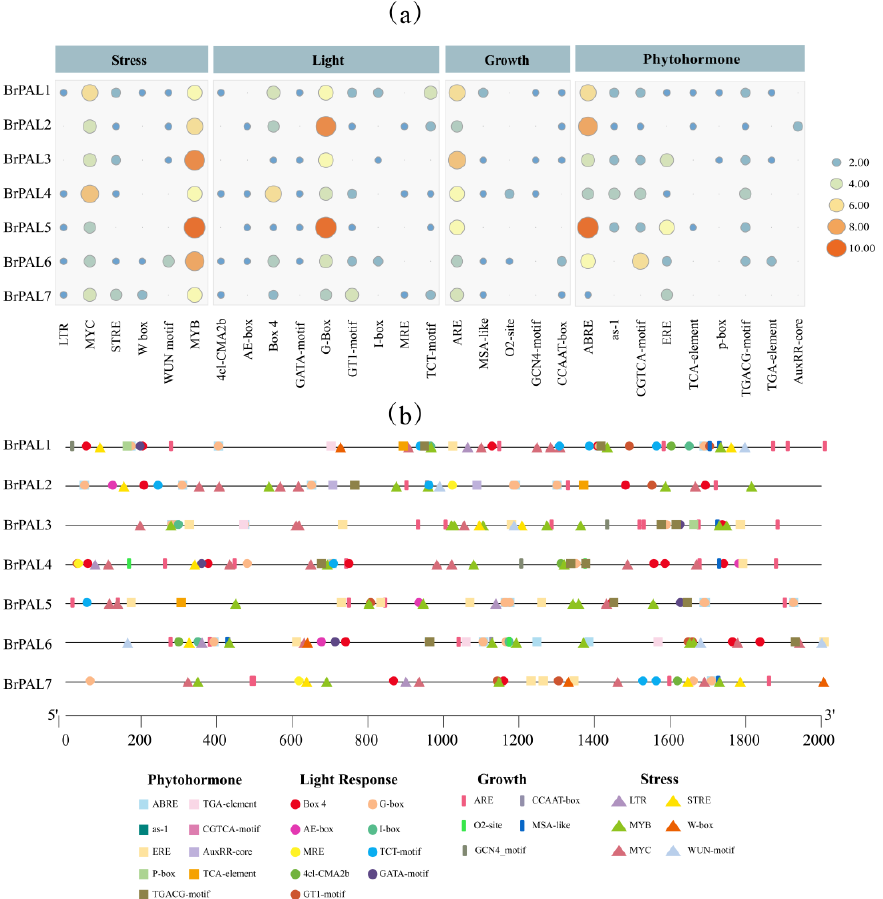
To further explore the potential role of cabbage PAL genes under different light quality, abiotic stresses and hormone treatments, we analyzed their expression levels using qRT-PCR. As shown in Figure 7, all members were down-regulated under FR and FU treatment, and all genes were up-regulated under UVA treatment except for BrPAL2 and BrPAL5 . As shown in Figure 8, only BrPAL2 and BrPAL5 expressions were up-regulated under heat stress reaching peaks at 6 h and 3 h, respectively, while the rest of the genes remained at low expression levels; except for the downregulation of BrPAL5 , the expression levels of other members were relatively high under treatment at low temperatures. The expression levels of BrPAL1 , BrPAL2 , and BrPAL3 at 0 – 12 h and BrPAL4 and BrPAL6 at 0 – 24 h gradually increased with time, and the expression of BrPAL6 increased in all members at 12 h of cold stress. Interestingly, the expression pattern of BrPAL2 was consistent under high-temperature and low-temperature treatment; the expression of BrPAL gene family members was downregulated under PEG and NaCl treatment, but there was a tendency to recover at 12 h and 24 h. As shown in Figure 9, the expression of the BrPAL gene family showed a trend of significant downregulation under